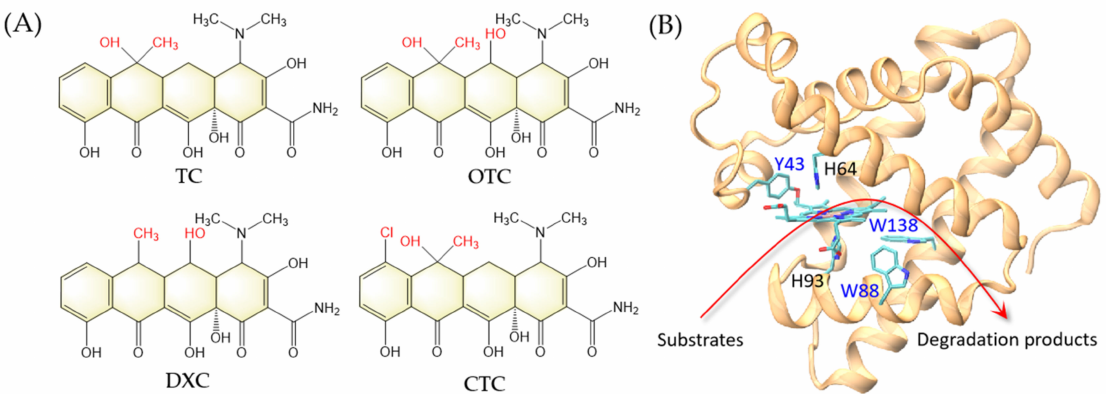
Figure 1. ( A ) Chemical structures of tetracycline (TC), oxytetracycline (OTC), doxycycline (DXC), and chlortetracycline (CTC). The structural differences are highlighted in red. ( B ) A model structure of F43Y/P88W/F138W Mb based on the X-ray structure of F43Y Mb (PDB code 4QAU [8]). The arrow indicates the peroxidase activity by degradation of